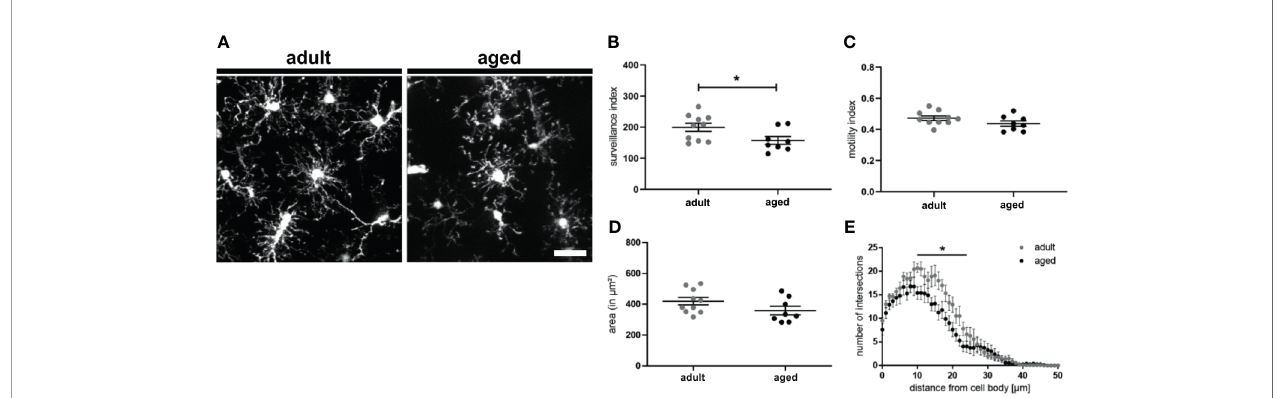
FIGURE 3 | Surveillance de fi cits and hypo-rami fi cation in aged microglia. (A) Representative two-photon images of microglia from acute slices of adult (7-8 months) and aged (13-16 months) mice. Semi-automated analysis of (B) surveillance index, (C) motility index and (D) area of adult and aged microglia. (E) Sholl analysis using max. z-projections from time point t 0 of respective time-lapse recording showing the number of intersections in relation to the distance of the cell body. n=8-10 cells from n=7 mice each, mean ± SEM, unpaired nonparametric t-test (Mann-Whitney), *p<0.05. Scale bar: 20